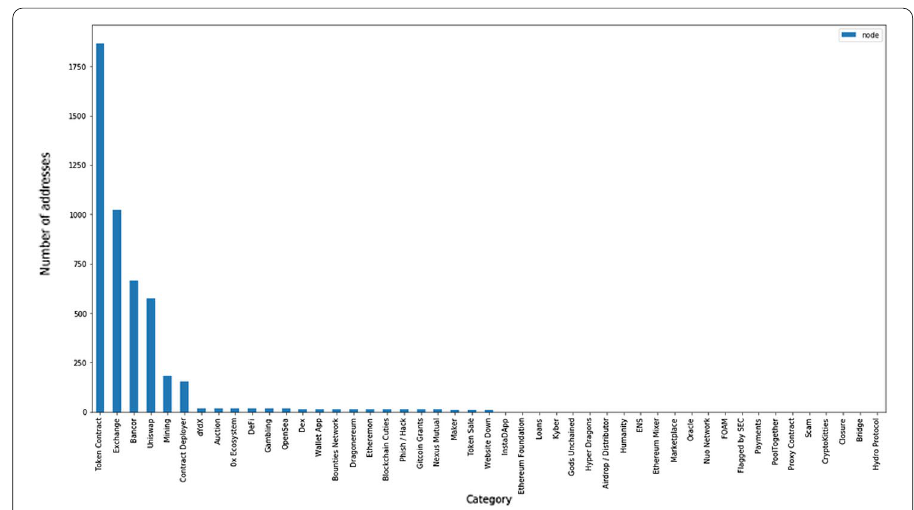
Fig. 12 Distribution of Ethereum testing addresses against the main categories of Etherscan